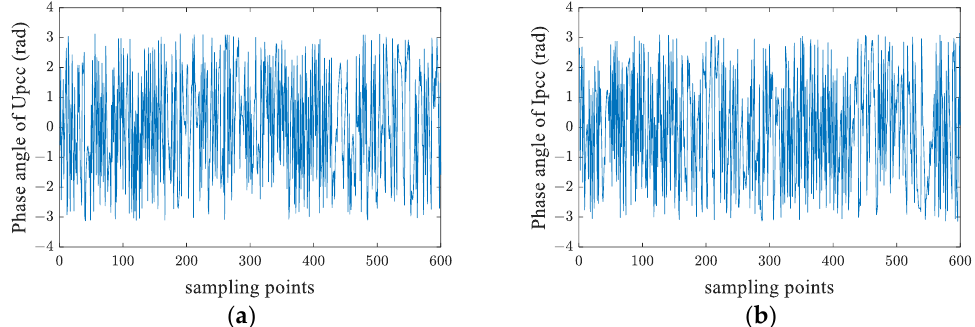
Figure 15. Third harmonic with load. ( a ) Harmonic voltage; ( b ) Harmonic current.